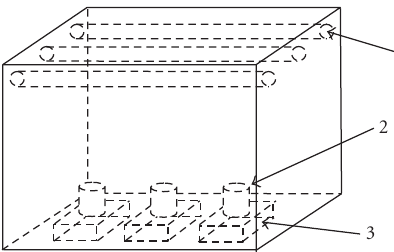
Figure 1: Schematic diagram of photocatalytic reactor. 1: fluores- cent tube (20W); 2: quartz petri dishes (diameter: 4.5cm; height: 12cm); 3: magnetic stirrers.